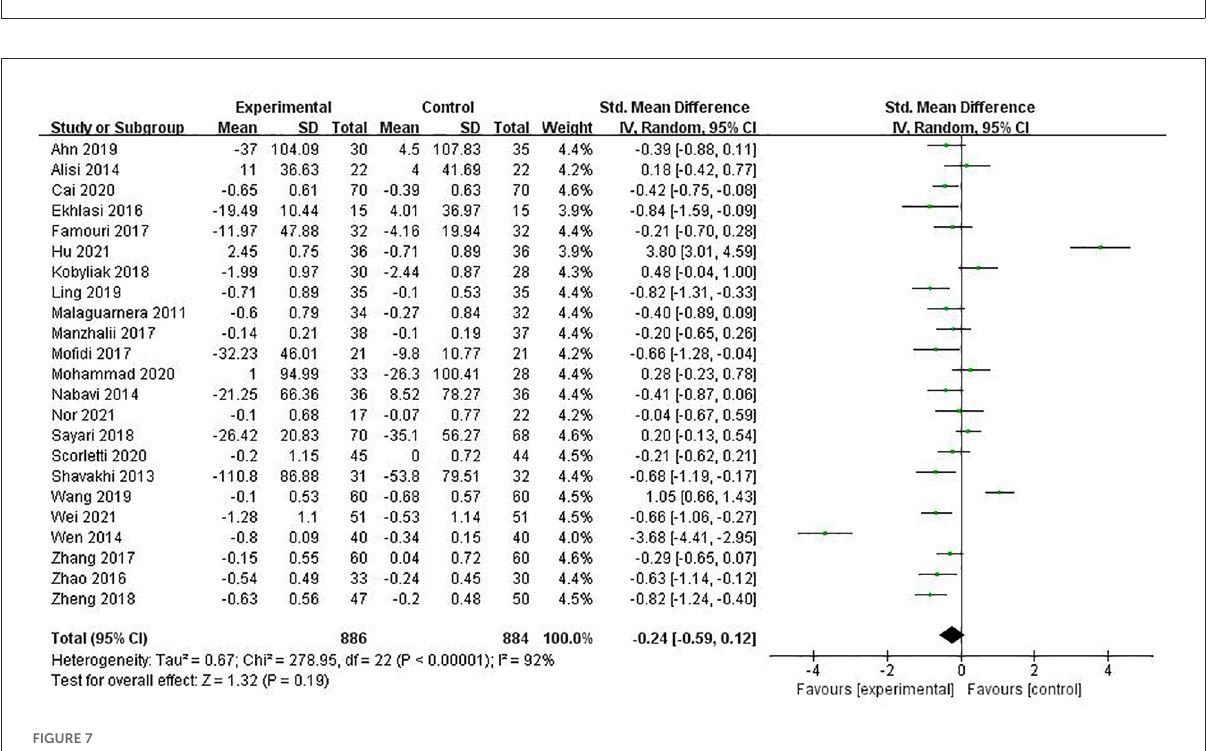
of NAFLD patients, there is a problem of elevated blood glucose (3), and studies by Mirmiranpour et al. have